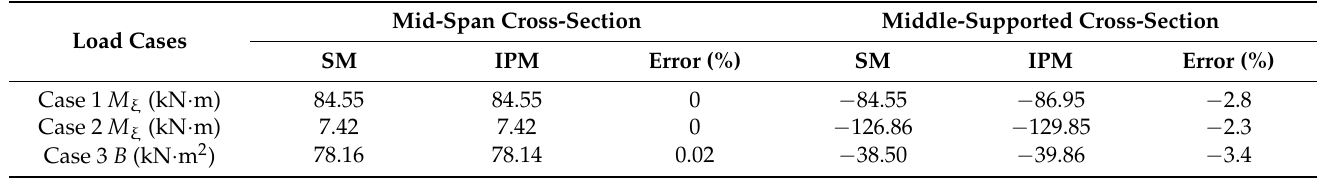
Table 1. Moment in the mid-span and middle-supported cross-section of